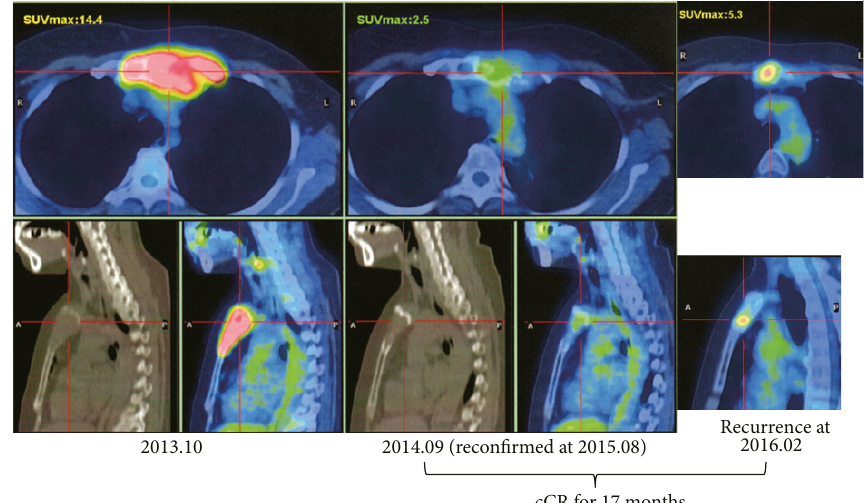
Figure 5: PET-CT of the sternum of Case #20 (assigned as cCR Case 3 ). A huge bone metastasis of breast carcinoma was observed. The length of cCR status was calculated between the reconfirmation of disease-free status on September 3, 2014, and the diagnosis of local recurrence on February 9,